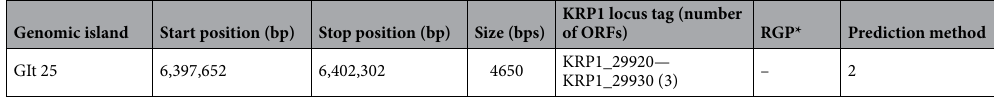
Table 2. Summary of genomic islands predictions in P. aeruginosa KRP1. GI: genomic island (> 10 kb), GIt: genomic islets (< 10 kb), PI: pathogenicity island, RI: resistance island, SI: symbiotic islands. Prediction method: 1: IslandPath-DIMOB 17 ; 2: SIGI-HMM 16 ; 3: PHASTER 18 ; 4: GIPSy 19 ; 5: manual blast against previously described P. aeruginosa GIs. *Reported regions of genomic plasticity — RGPs 1–62 30 ; RGPs 63–80 32 ; RGPs 81–86 15 ; RGPs 87–89 33 .